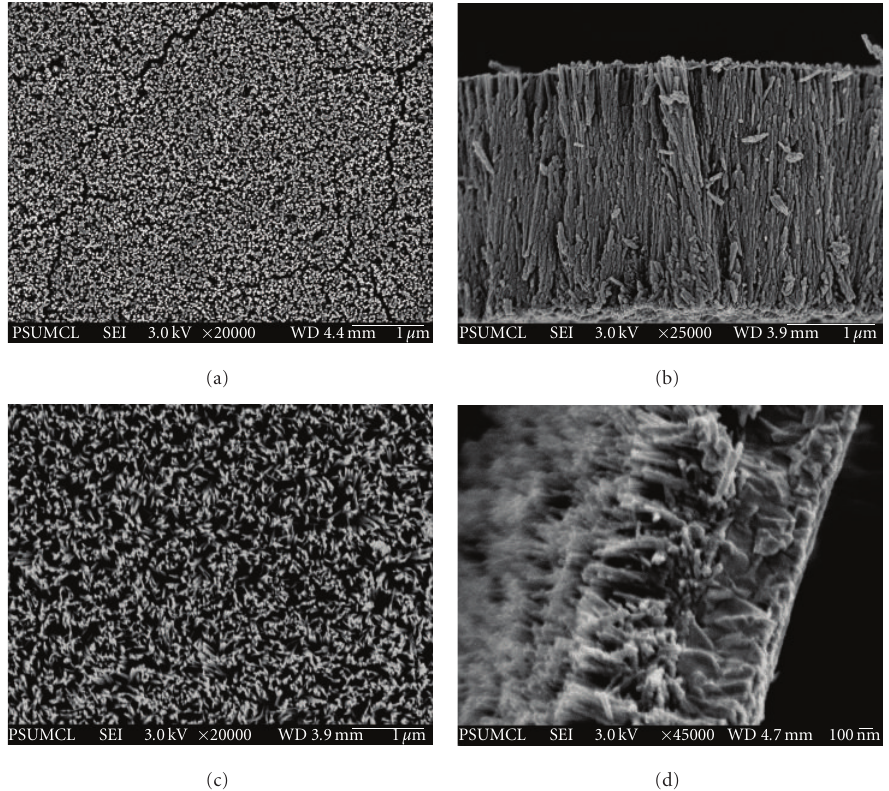
Figure 2: (a) Top and (b) cross-sectional FESEM images of vertically oriented self-organized rutile TiO 2 nanowire array grown on FTO coated glass at 180 ◦ C for 24 h. Reprinted with permission from [24]. (c) Top-view and (d) cross-sectional FESEM image of short rutile TiO 2 nanowire